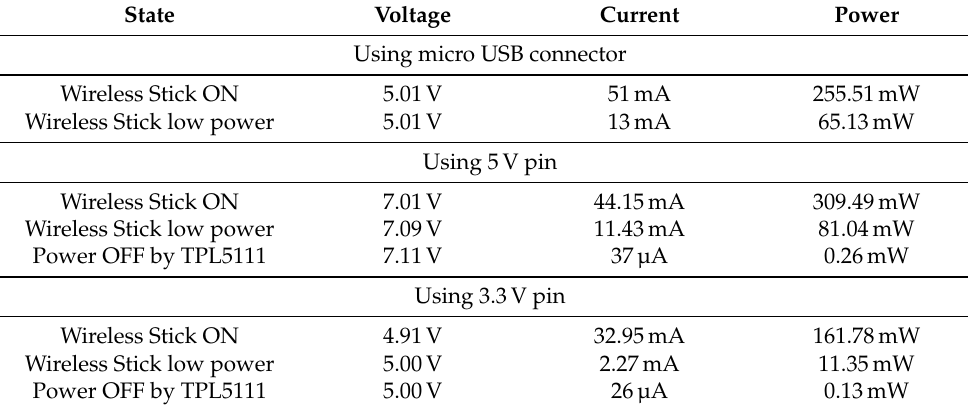
Table 1. Power consumption based on Vdd input pin